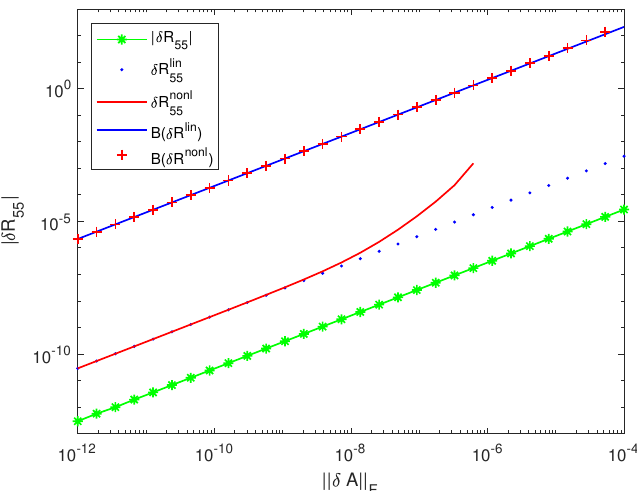
Figure 7. Exact values of δ R 55 and its bounds as functions of the perturbation norm.